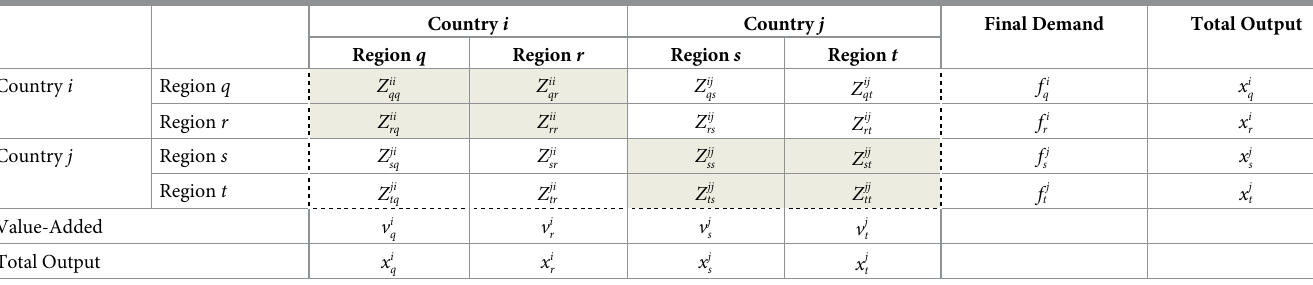
Table 1. A simplified inter-regional input–output